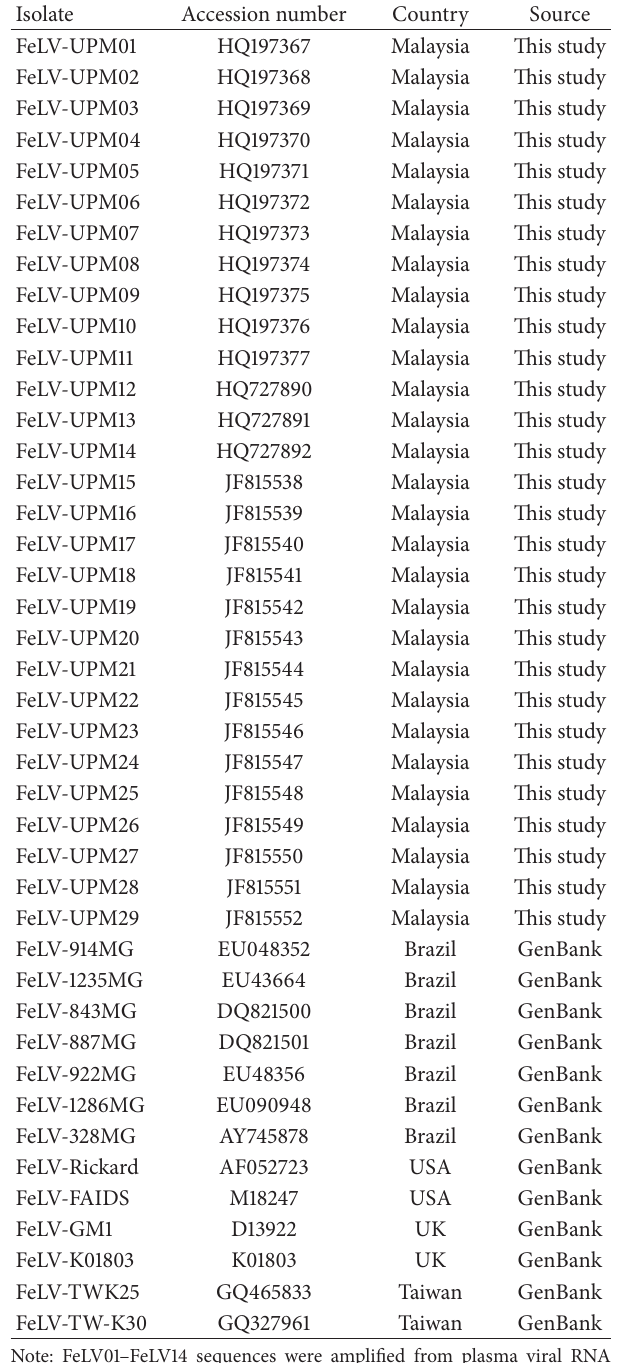
Table 1: List of local and reference sequences used in phylogenetic analysis of Malaysian FeLV